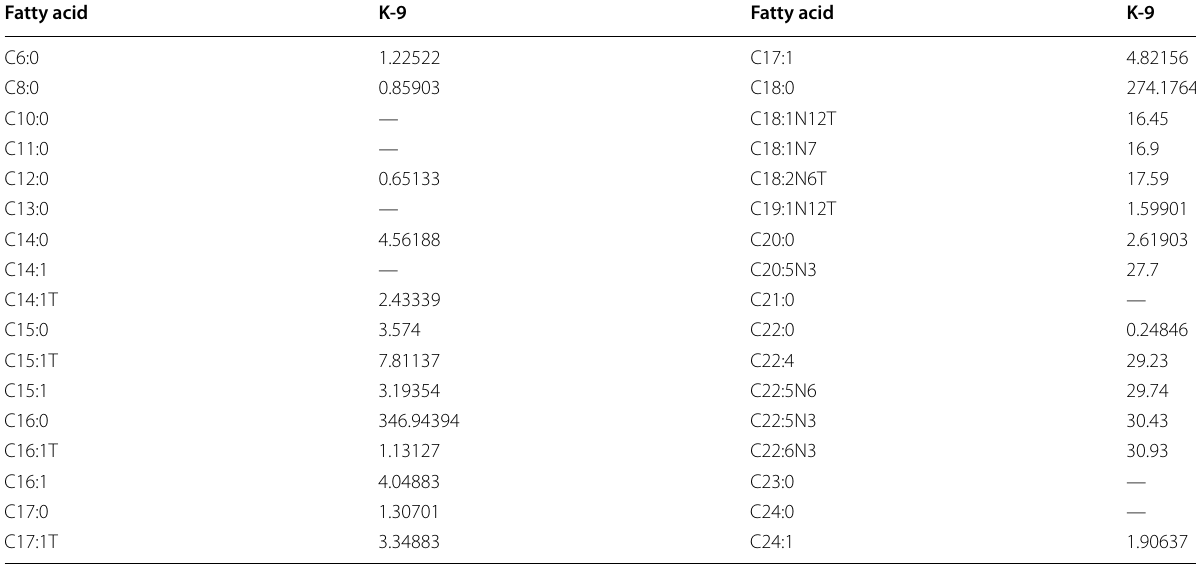
Table 3 Cellular fatty acid (μg/g) compositions of strain K-9 T